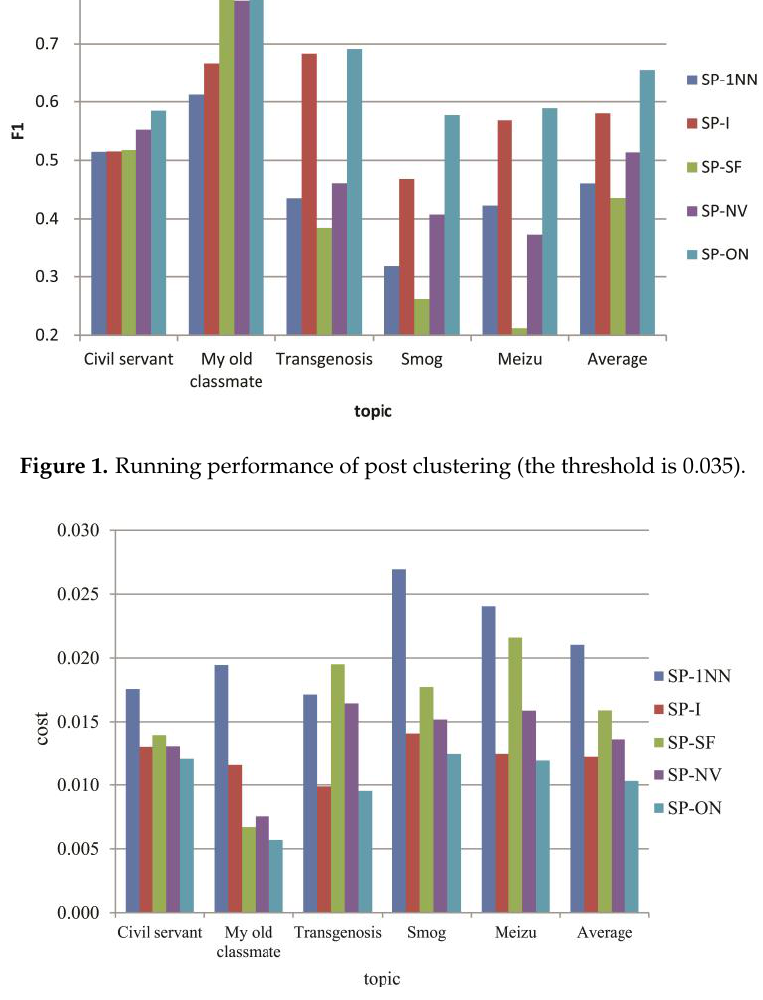
Figure 2. Running cost of post clustering (the threshold is 0.035).